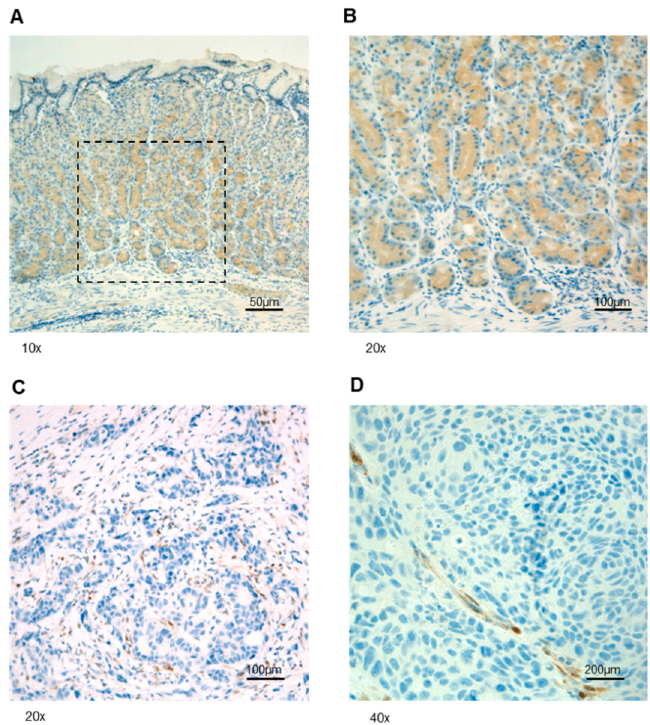
Figure 2. Representative IHC staining of PTEN protein expression in tissues from the index case. ( A ) Normal gastric epithelium showing cytoplasmic staining. ( B ) Higher magnification of the squared area shown in ( A ). ( C , D ) GEJ tissue showing positive staining in normal stromal ( C ) and endothelial ( D ) cells and a lack of reactivity in cancer cells.